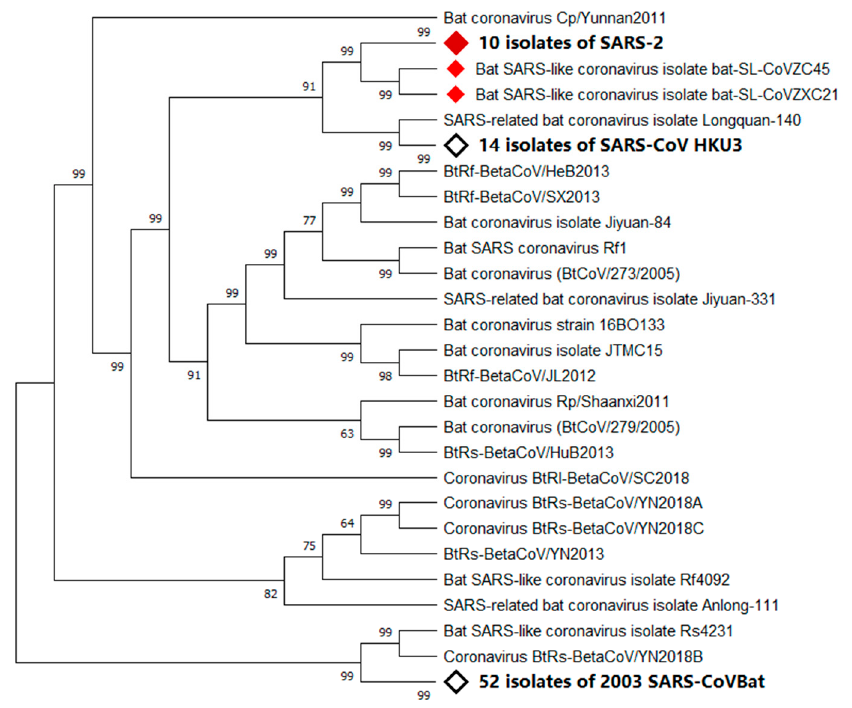
Figure 1. Phylogenetic analysis of virus isolated from severe acute respiratory syndrome (SARS)-2 patients. Sequence of Wuhan seafood market pneumonia virus isolate Wuhan-Hu-1 was used for comparing with whole genome sequence database from National Center for Biotechnology Information (NCBI) by using Basic Local Alignment Search Tool (BLAST). MAFF (AIST) was used to align the first 100 matching sequences. Phylogenetic trees were constructed by using MEGA X through neighbor-joining (NJ) methods. According to the phylogenetic tree, SARS-2, bat SARS-like coronavirus isolate bat-SARS-like coronavirus (SL-CoV) ZC45, and bat SARS-like coronavirus isolate bat-SL-CoVZXC21 share a common ancestor.